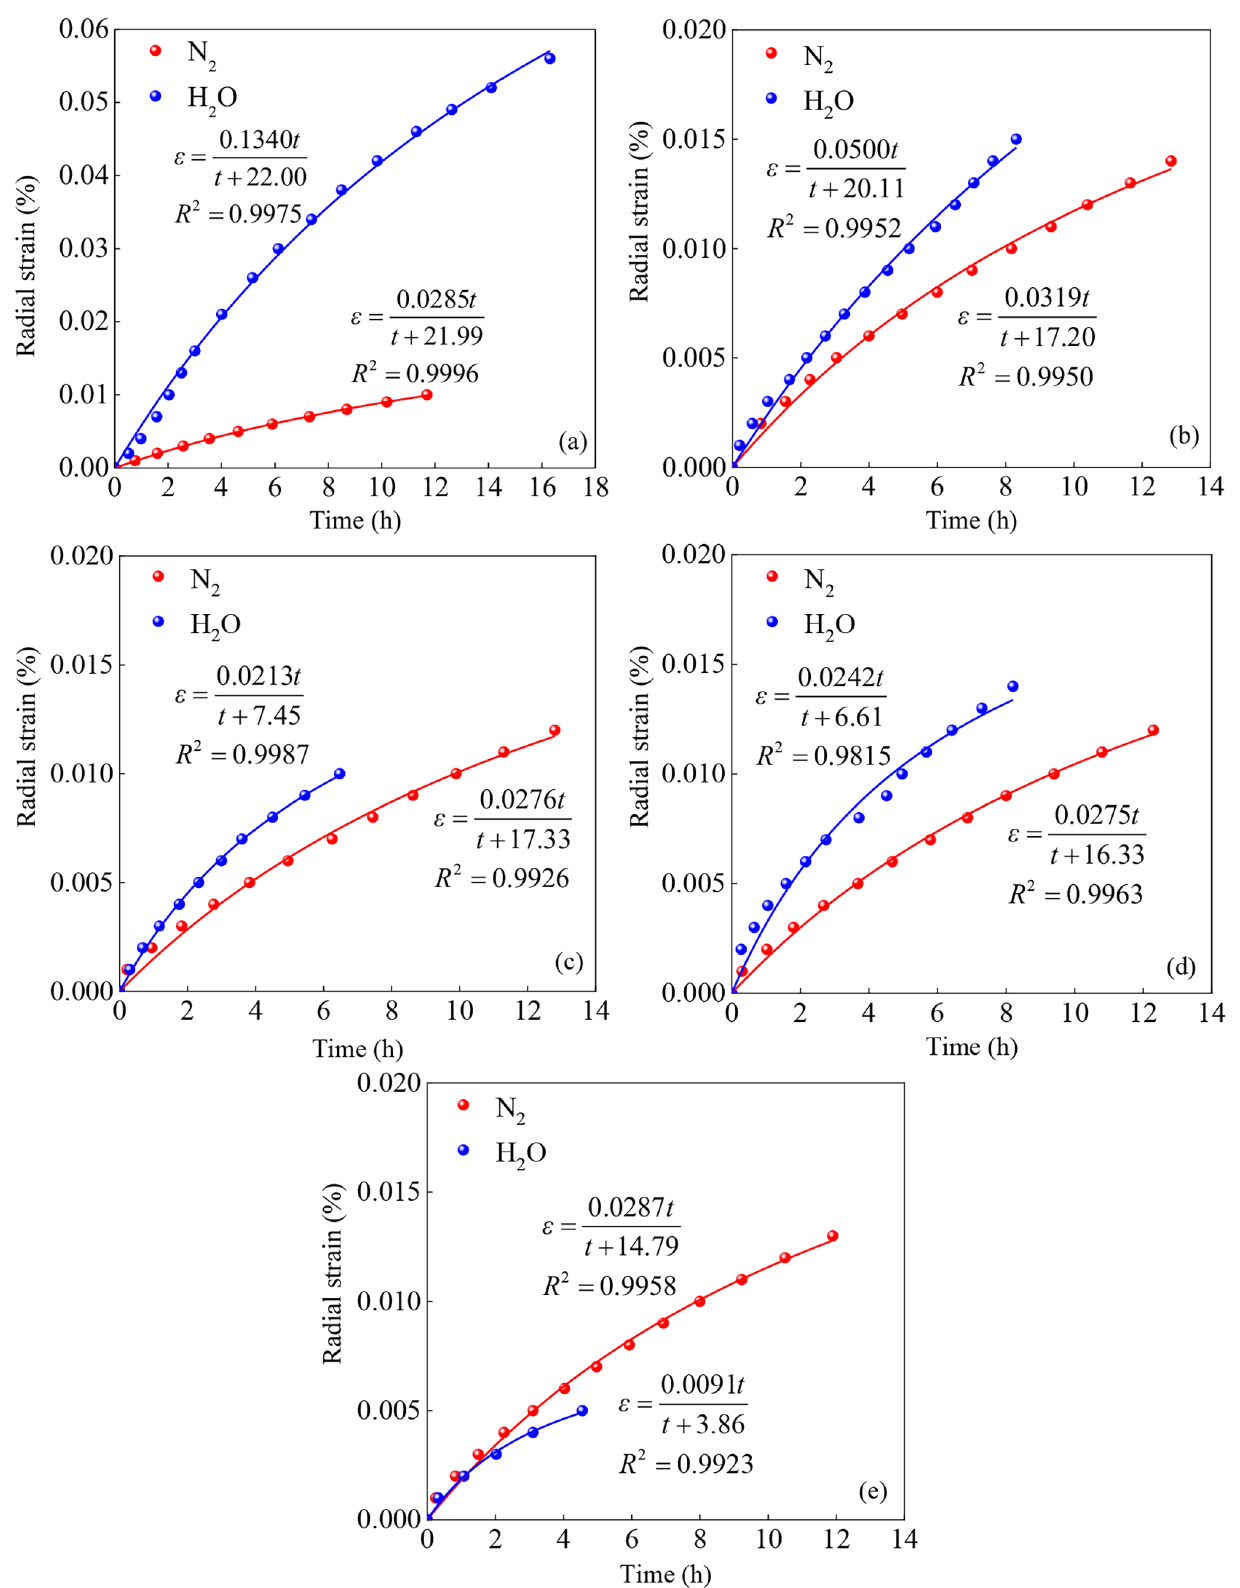
Fig. 2 Radial strain versus time for N 2 and water injection. a 1 MPa; b 1.5 MPa; c 2 MPa; d 2.5 MPa and e 3